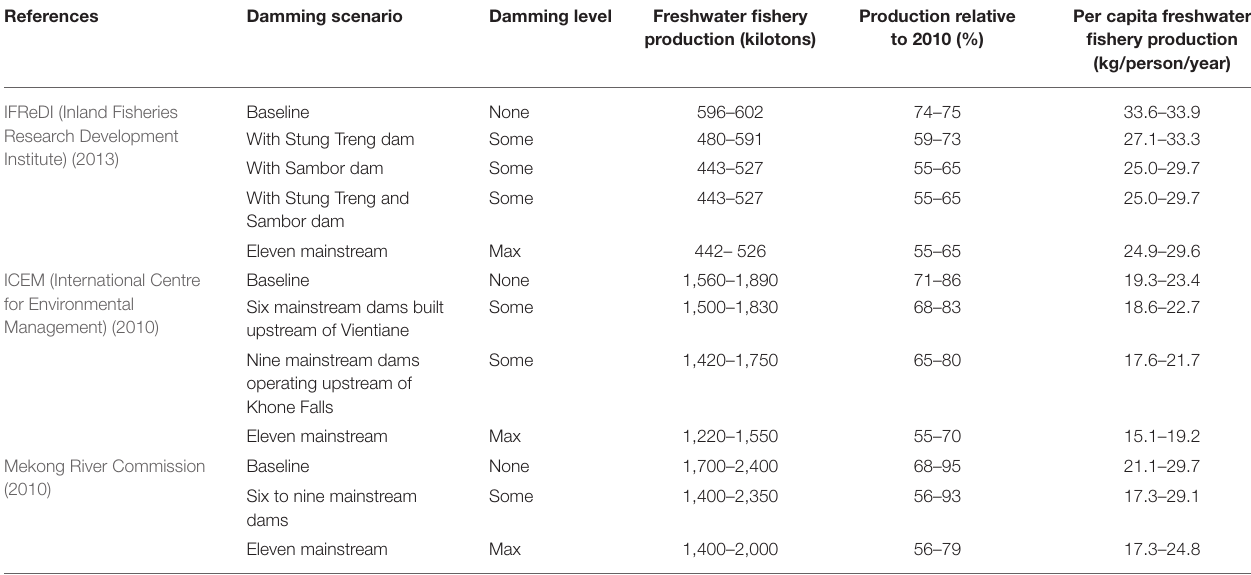
TABLE 2 | Summary of projected capture fishery production changes for each reviewed